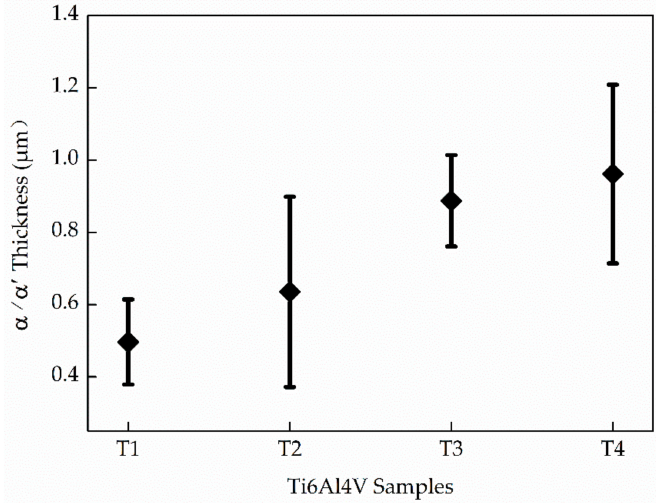
Figure 8. The thickness of the α / α ’ phases of the four